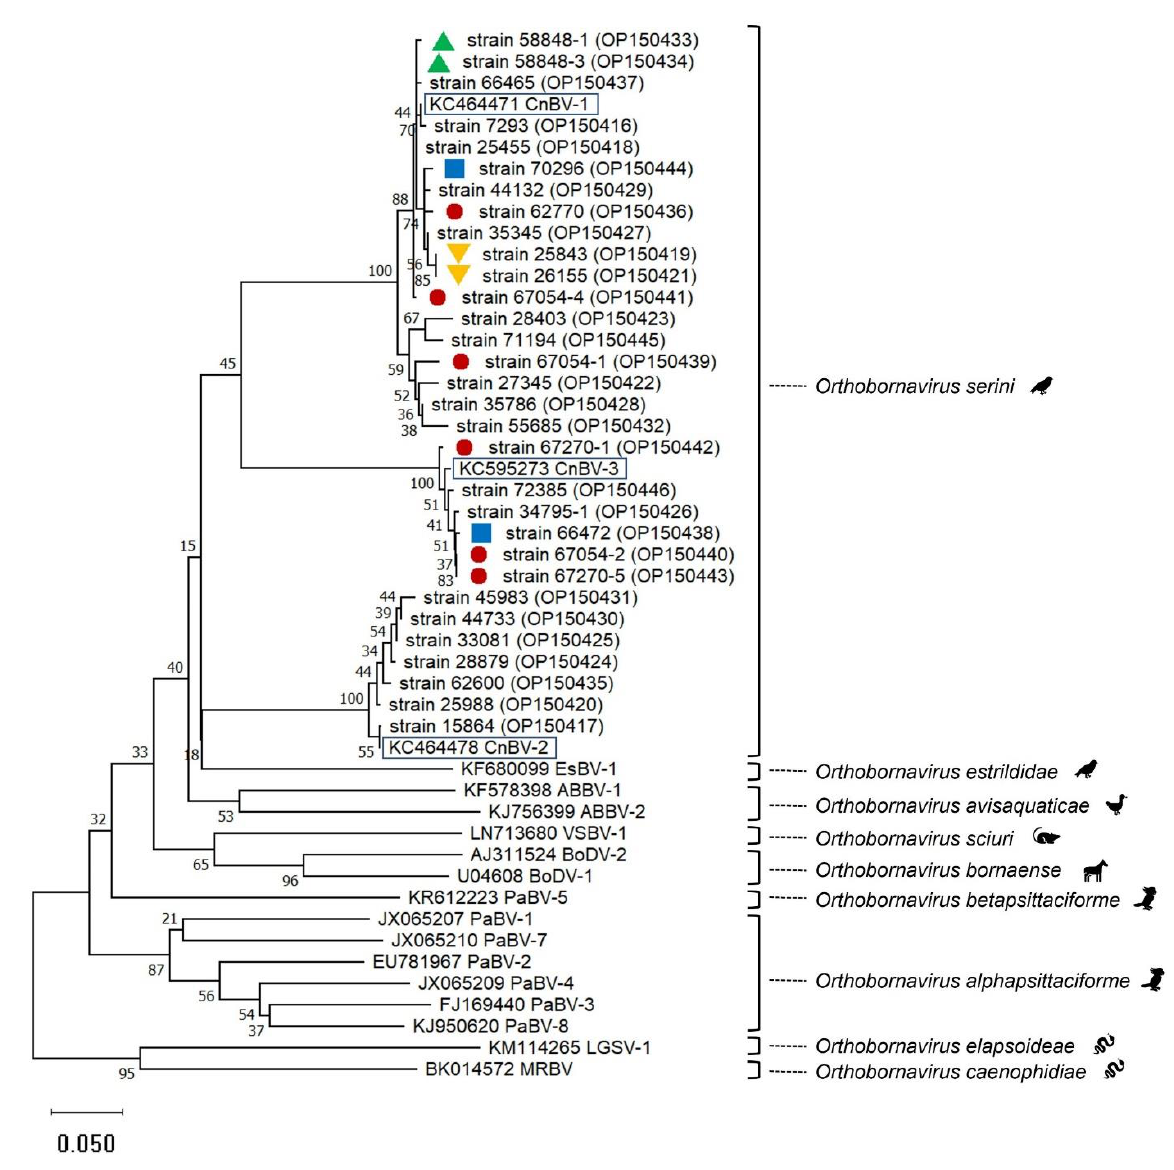
Figure 1. Phylogenetic relationship based on CLUSTALW alignments and neighbor-joining analyses including bornavirus partial N gene nucleotide sequences (0.35 bp) from 31 canaries (this study, strain names with GenBank accession numbers in brackets are given) and representatives of the 9 species included in the genus Orthobornavirus (GenBank accession numbers starting with letters are given). Representatives of the three viruses included in the species Orthobornavirus serini are highlighted by black boxes. Red circles, blue squares, as well as green or orange triangles, mark origin from the same flocks. The other canary-bornavirus strain sequences of this tree originated from different flocks. Sequences obtained in this investigation are available in GenBank under the accession numbers OP150416-OP150446.